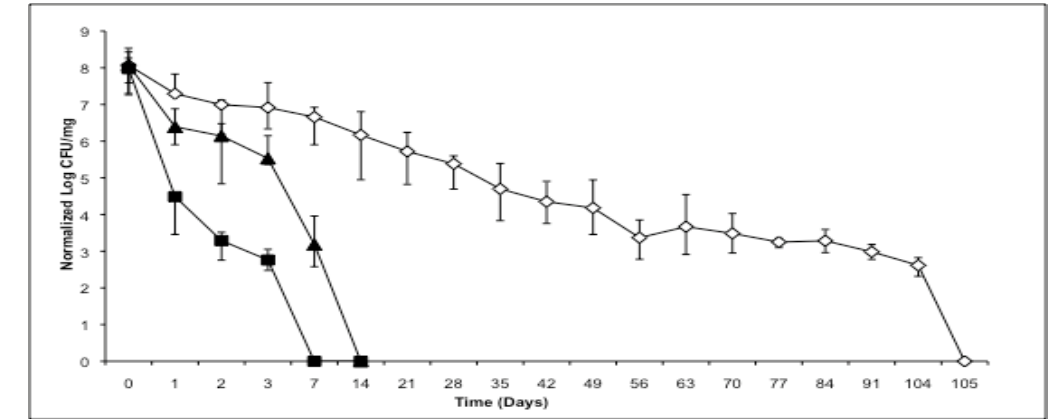
Figure 1. Viability comparison of dry powder M. smegmatis spray dried under various conditions. Normalized log CFU viability of M. smegmatis spray dried at log phase growth and stored at 40  C (  ). Normalized log CFU viability of M. smegmatis spray dried at stationary phase growth and stored at 40  C (  ). Normalized log CFU viability of multiply cycled M. smegmatis stored at 40  C (  ). Error bars represent maximum and minimum CFU at each time point across n. For cycled bacteria n = 3 was performed on the final (fourth)